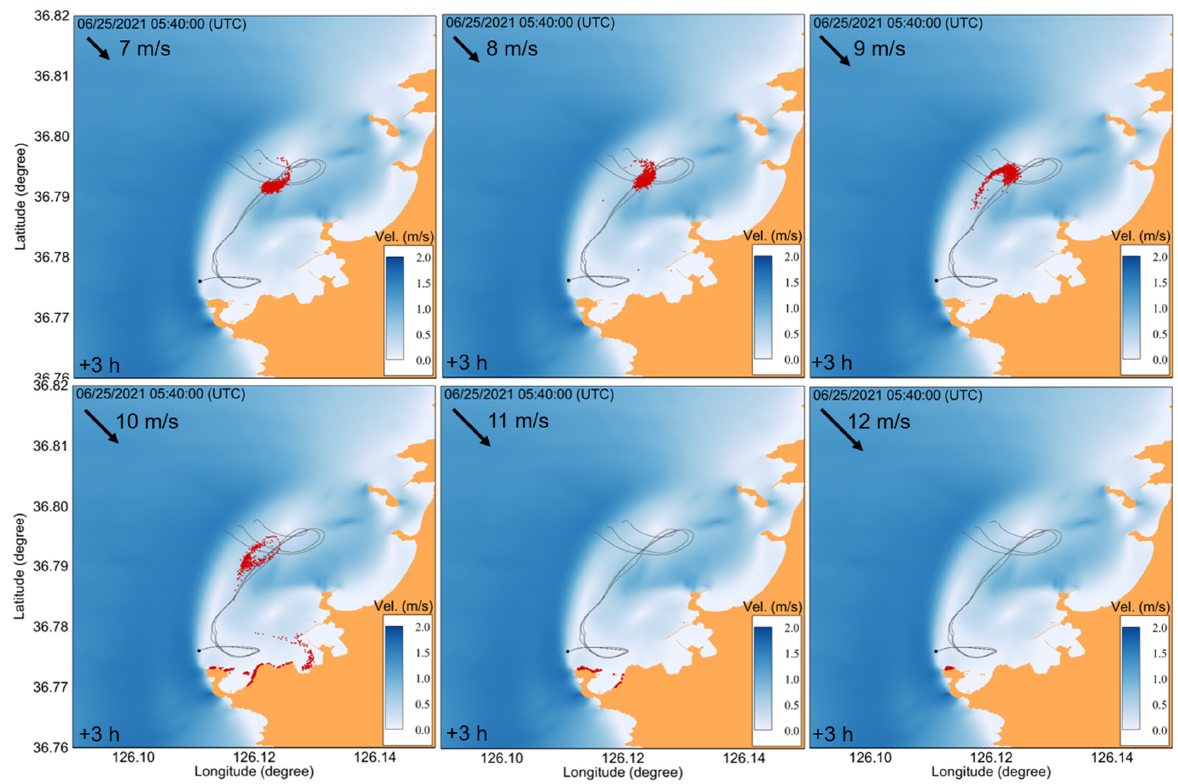
Figure 15. Simulated results depending on the wind effect on particle tracking after 3 h of floating; wind speeds are denoted in the upper-left corner of each